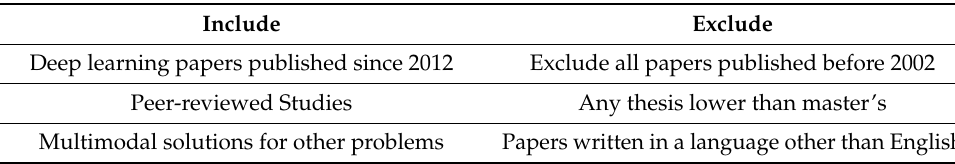
Table 1. Literature inclusion and exclusion criterion.